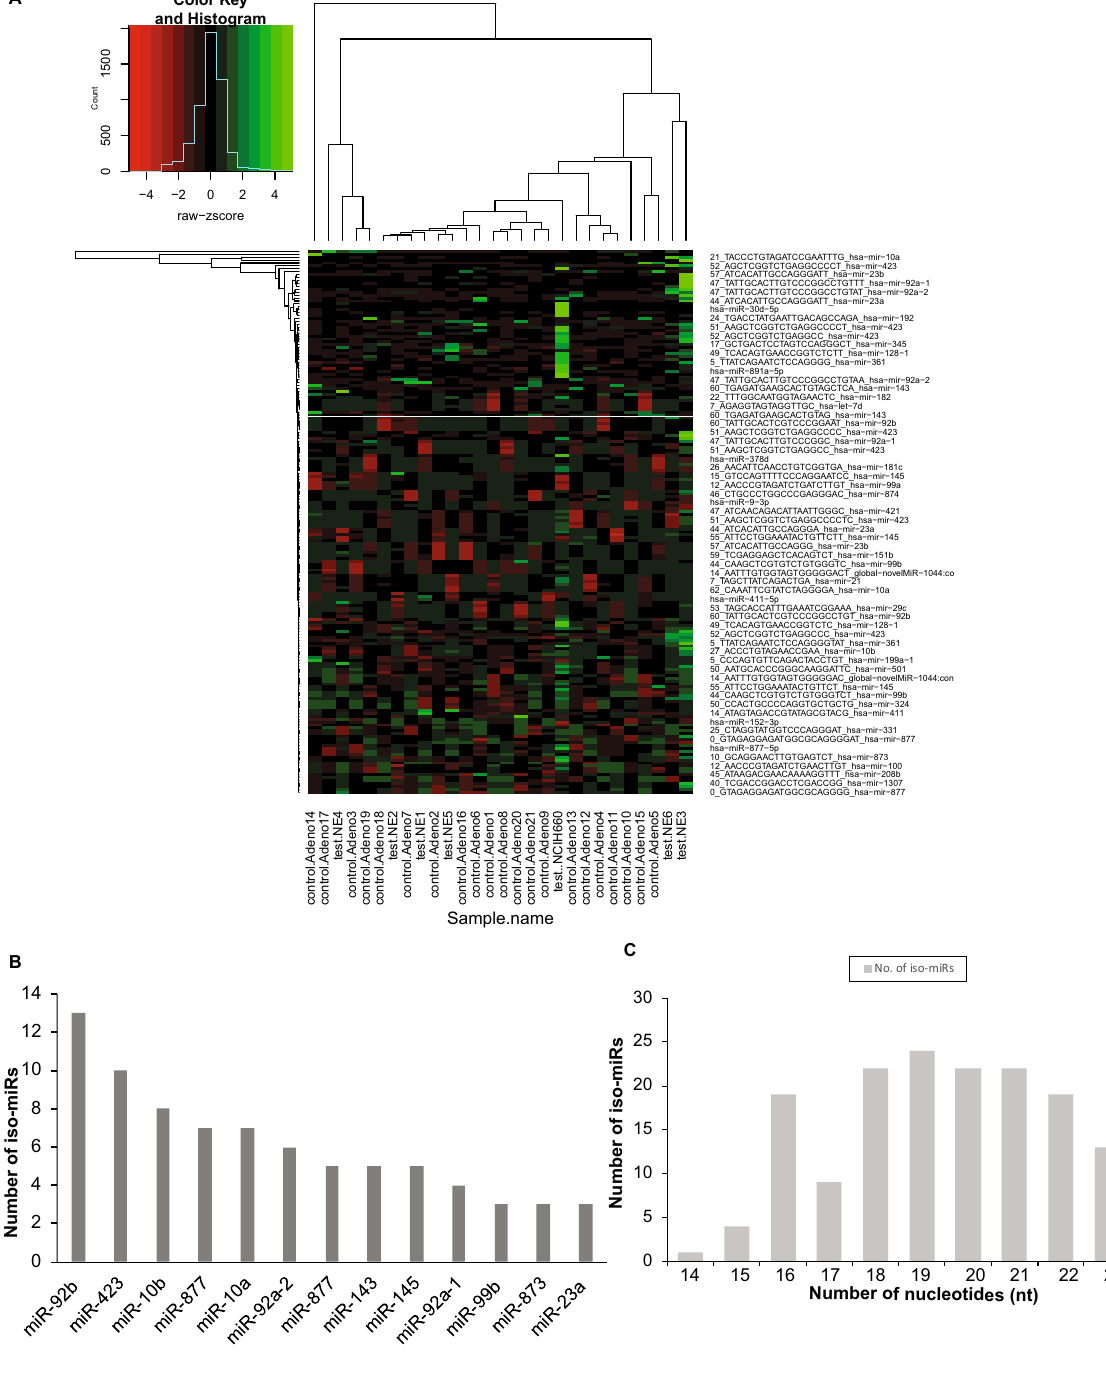
Figure 2. Predominant dysregulation of miRNA isoforms in EVs from NEPC. ( A ) Heat map showing differentially expressed iso-miRs in EVs from CRPC-adeno cases (n = 21) as compared to CRPC-NE (n = 6 clinical tissues + NCI-H660 cell line). Heat map was generated by using R studio software, Version 1.1.463 (https:// www. npackd. org/p/ rstud io/1. 1. 463). ( B ) miRNA loci producing ≥ 3 differentially expressed iso-miRs in sequenced samples plotted as a function of number of observed iso-miRs. ( C ) Range of length of differentially expressed iso-miRs (14–24 nucleotides) and their abundance across sequenced EV miRNAs extracted from CRPC-Adeno and CRPC-NE